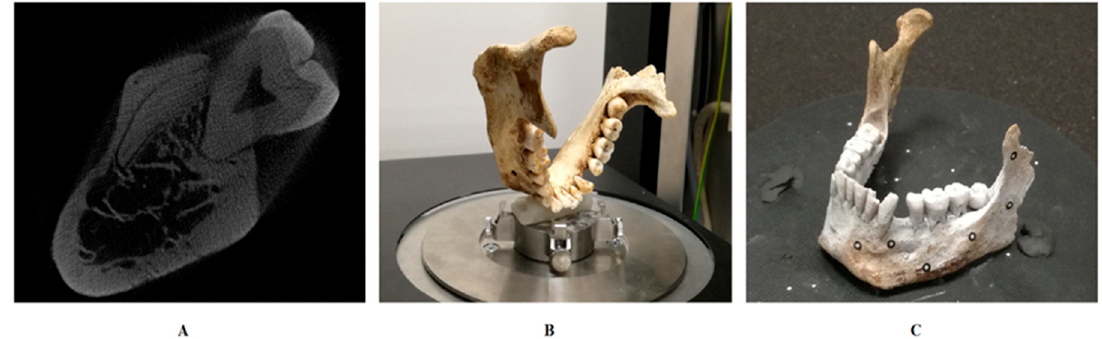
Figure 1. Different methods of obtaining a three-dimensional image of a human mandible. ( A ) Human mandible cone beam tomography (CBCT) cross-section. ( B ) Human mandible prepared for microtomography. ( C ) Human mandible prepared for extraoral scanning.